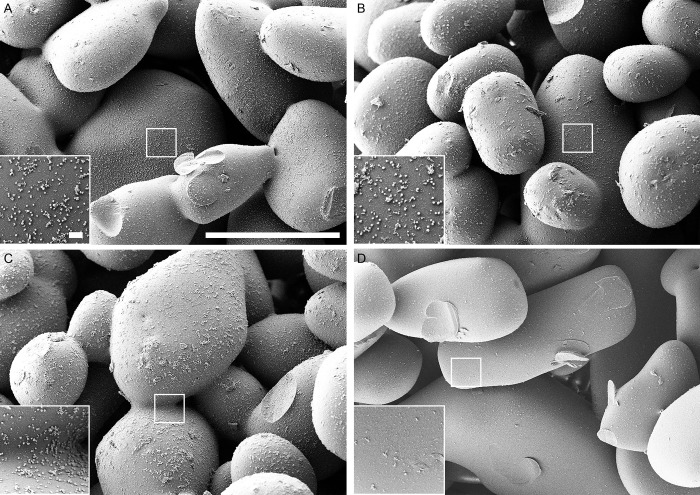
Scanning electron microscopy (SEM) of S. aureus biofilm.(A) beads after 0.9% NaCl treatment (control). (B) beads after EDTA treatment. (C) beads after DTT treatment. (D) beads after sonication treatment. Scale bars: 200 μm (inserts in the images represent 5 μm).